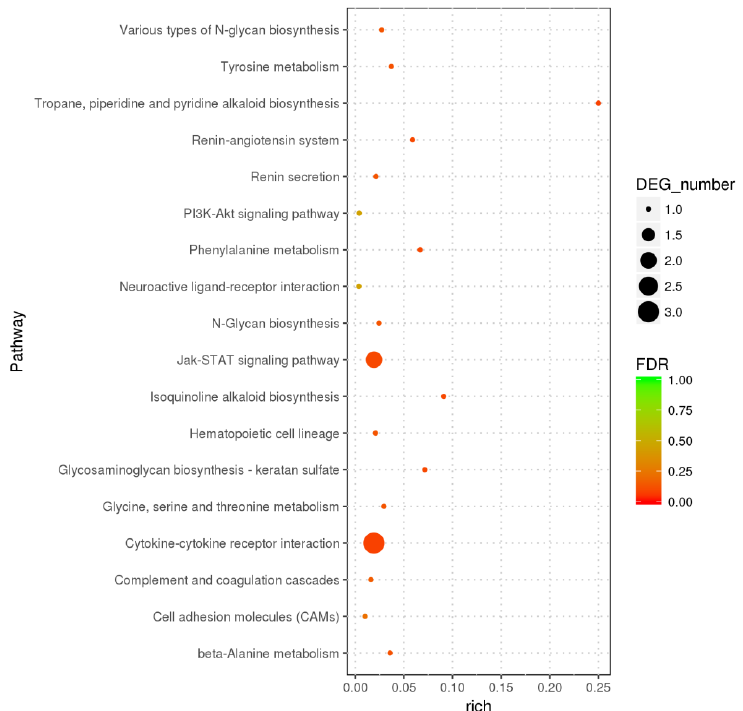
Figure 1. Kyoto Encyclopedia of Genes and Genomes (KEGG) analysis of the control and ovarian tumor deubiquitinase 7A ( OTUD7A ) overexpression groups in goose hepatocytes. Primary hepatocytes were isolated from goose embryos after 23 days of incubation. The cells transfected with the empty pcDNA3.1(+) vector were used as controls, while those transfected with pcDNA3.1(+) containing the OTUD7A coding sequence were used for overexpression. Differentially expressed genes (DEGs) were identified using DESeq2 R software. The DEGs were selected based on genes showing a fold change in OTUD7A overexpression compared to the control group of >2 or <0.5, and p -value < 0.05. The clusterProfiler R package was used to statistically analyze the enrichment of the DEGs in the KEGG pathways.